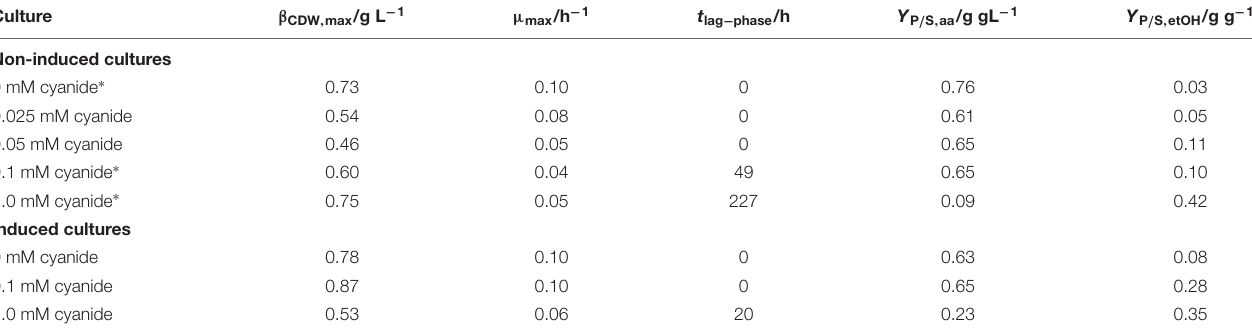
TABLE 1 | Results for CDW, growth rate, lag-phase, and product yield of heterotrophic cultures in the presence of different concentrations of cyanide. Culture